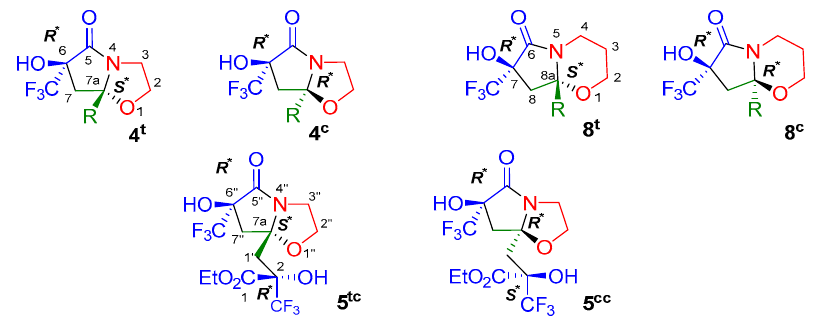
Figure 2. Diastereomeric structure of heterocycles 4 , 5 and 8 .